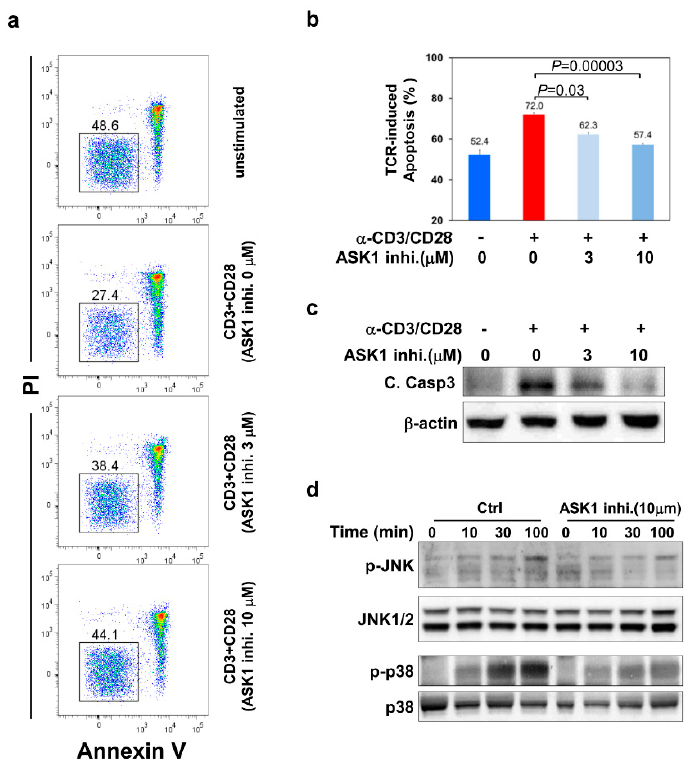
Figure 2. The ASK1- JNK / p38 pathways are critical for TCR-induced apoptosis of thymocytes. Thymocytes were either unstimulated or stimulated with anti-CD3 (10 µ g / mL) and anti-CD28 (1 µ g /